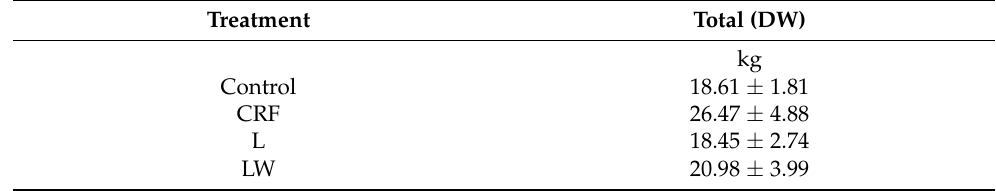
Table 5. Total mean dry weight (DW) per treatment. Six-year-old HLB-affected ‘Ruby Red’ grapefruit trees grafted on sour orange rootstock were used. Treatments consisted of two liquid (L and LW) and two granular fertilizers (Control and controlled-release fertilizer (CRF)). Data represents means ± standard